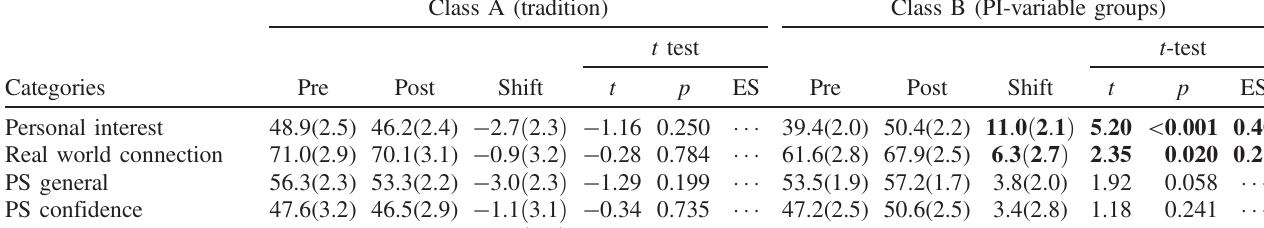
TABLE III. Scores in % favorable response ( (cid:2) standard error) of each individual category of the pre and post-CLASS test for classes A, B, C, and D. Shifts in bold text indicate significance ( p < 0 . 05 ). Paired sample t tests are